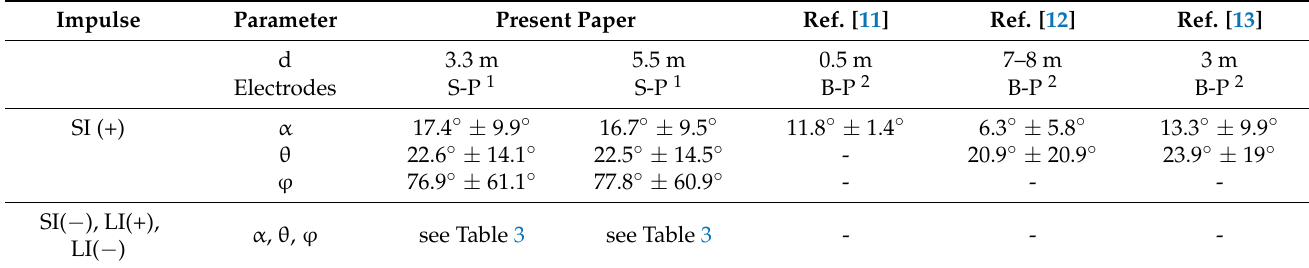
Table 4. Comparison of measurement results for tortuosity angles α , θ , ϕ ; d—distance between electrodes. Impulse